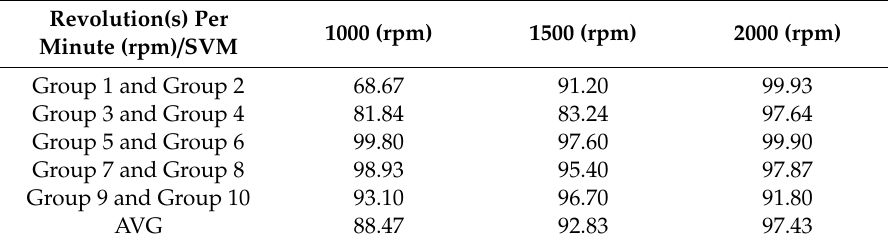
Table 6. Accuracy results of SVM at di ff erent rotational